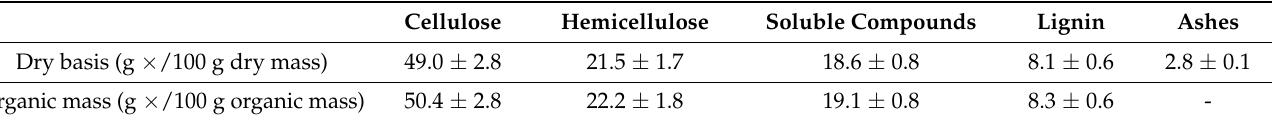
Table 3. Cell wall hemp shiv composition by Van Soest method (% w / w ). Number of repetitions = 6. Cellulose Hemicellulose Soluble Compounds Ashes Dry basis (g × /100 g dry